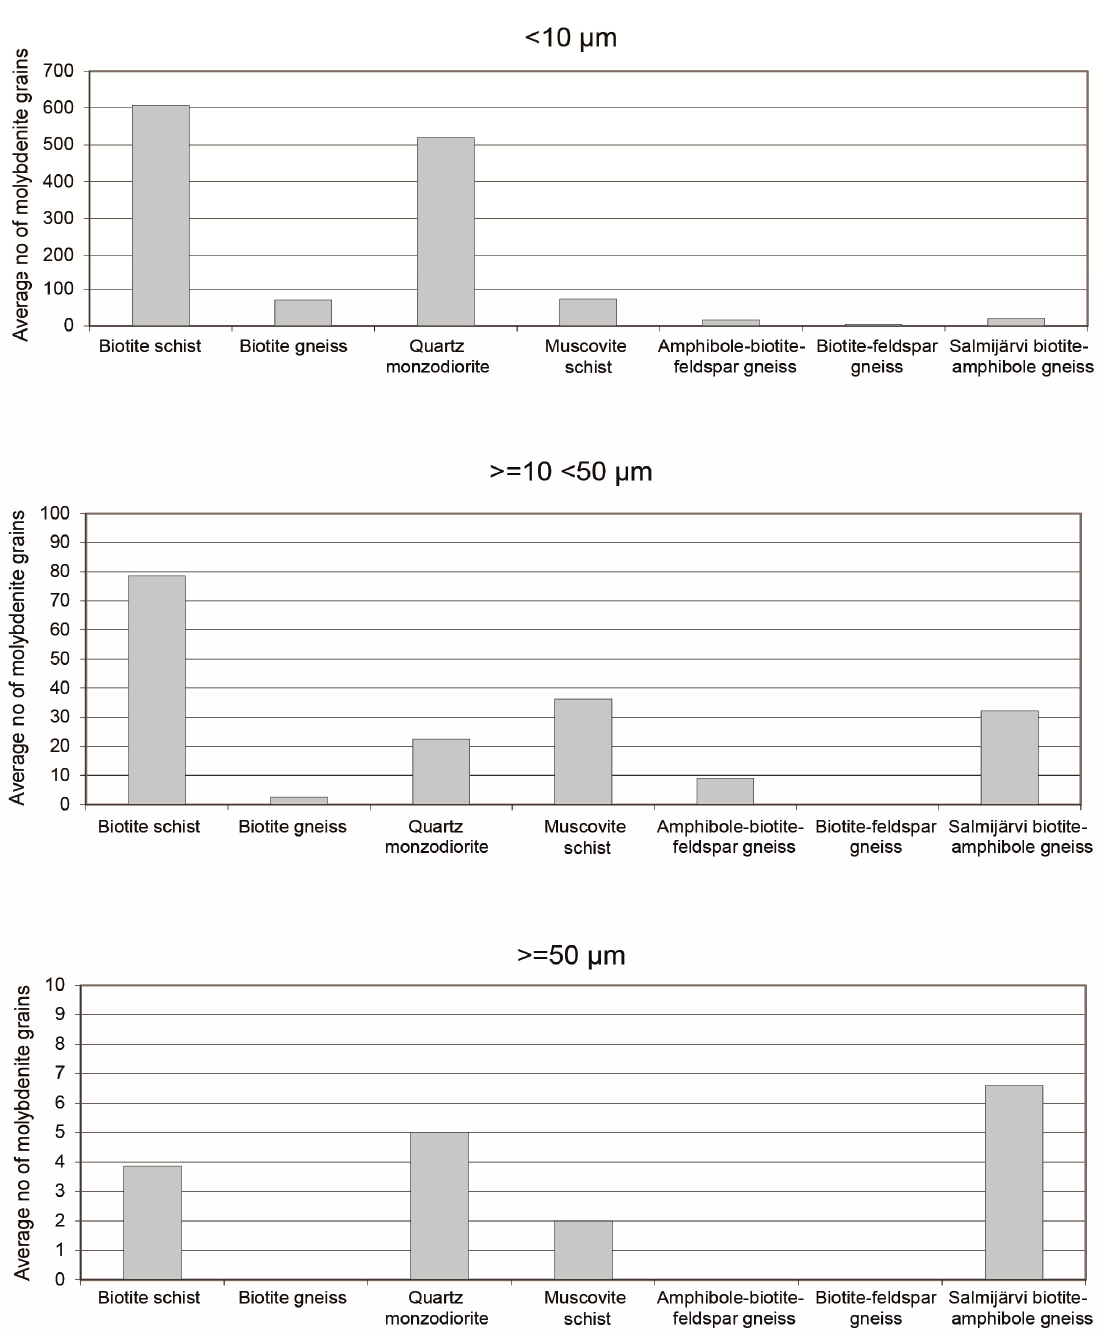
Figure 4. Average number of molybdenite grains displayed for each rock type and for three different size fractions. Graphs are based on number of grains detected by QEMSCAN in 31 polished thin section samples of 26 mm × 46 mm